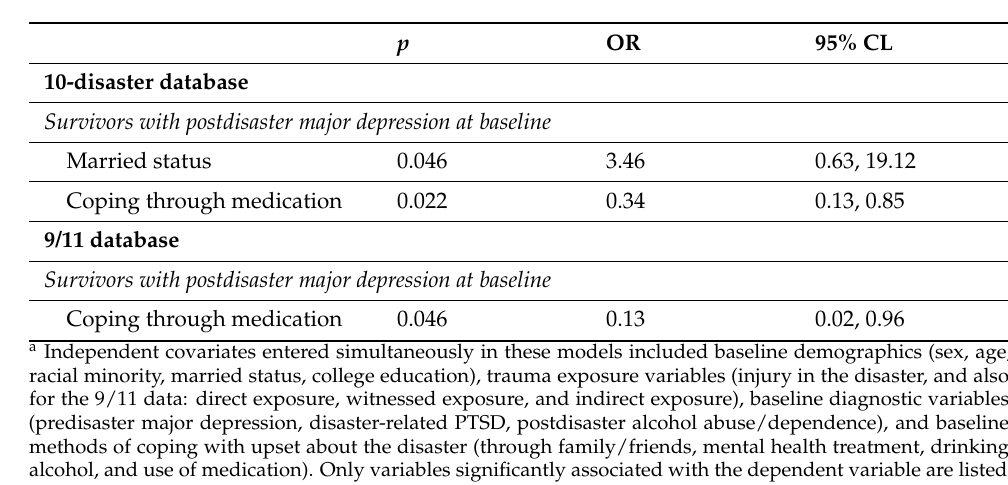
Table 1. Multivariate models predicting postdisaster major depression remission in the 10-disaster and 9/11 databases a